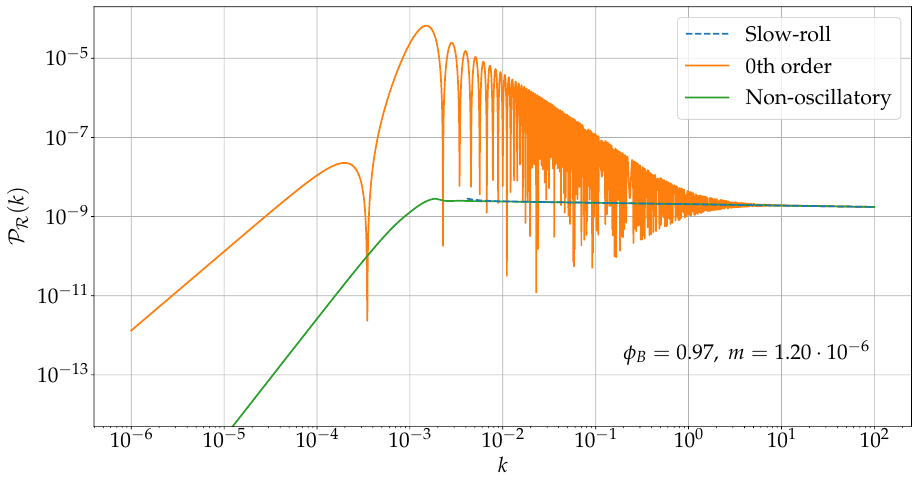
Figure 4. The primordial scalar power spectrum in hybrid LQC for the NO-vacuum on the background solution studied in Section 5. The power spectrum obtained with the 0th-order adiabatic state and with the slow-roll approximation (26) are also shown for